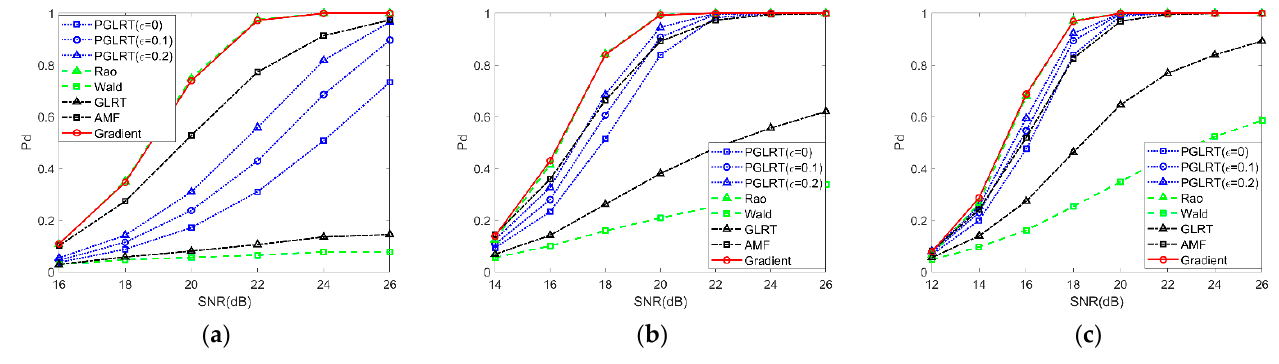
Figure 3. P d versus SNR for N = 16, cos 2 θ = 0.46: ( a ) K = 24; ( b ) K = 32; ( c ) K = 40.